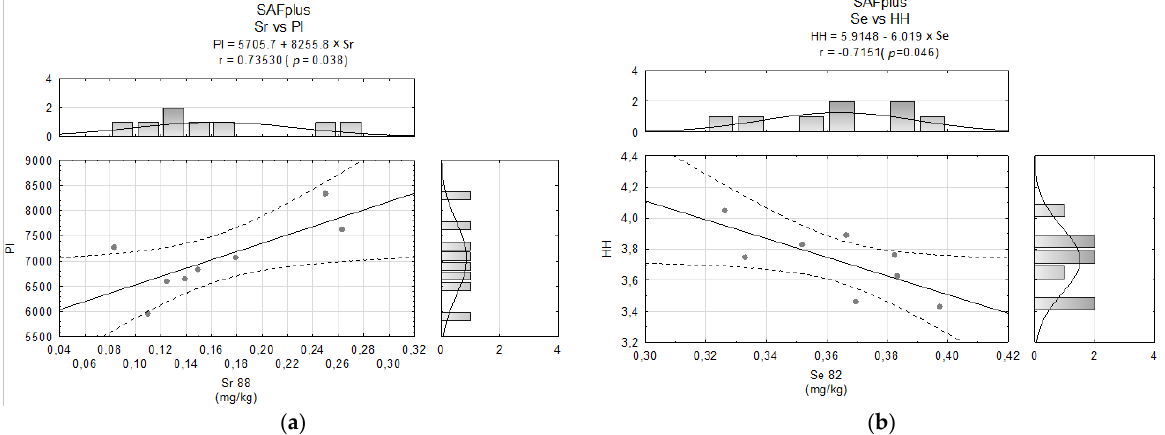
Figure 6. Correlations between ( a ) Sr content and peroxidability index and ( b ) Se content and HH index in the SAFplus group.